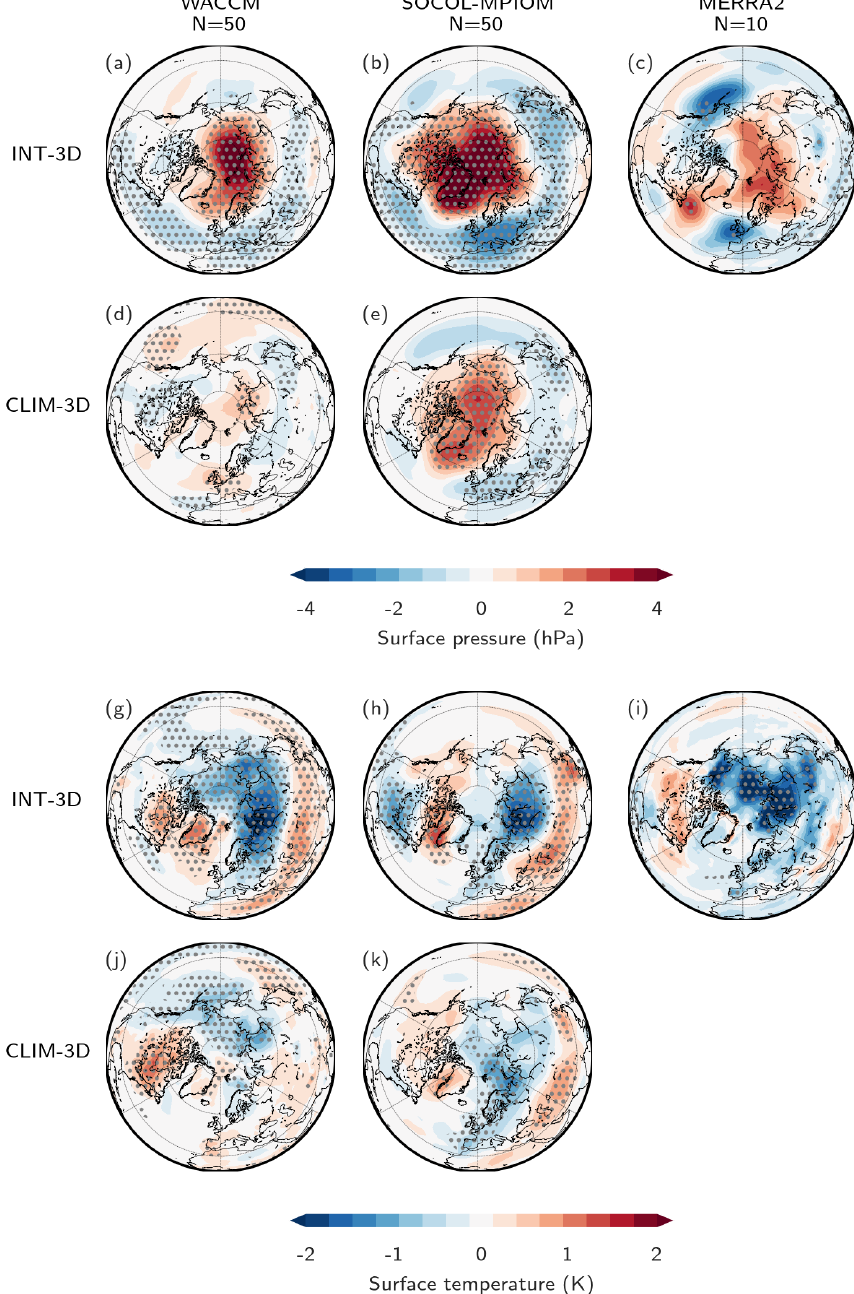
Figure 4. The surface impact of FSWs in high-ozone springs and the impact of ozone. SLP (a–e) and temperature (f–j) anomalies in the month after the 50hPa FSW date in high-ozone springs for WACCM INT-3D (a, f) , SOCOL-MPIOM INT-3D (b, g) , MERRA2 (c, h) , WACCM CLIM-3D (d, i) , and SOCOL-MPIOM CLIM-3D (e, j) . Stippling shows significance on a 4.6% level (2 σ ) following a bootstrap- ping